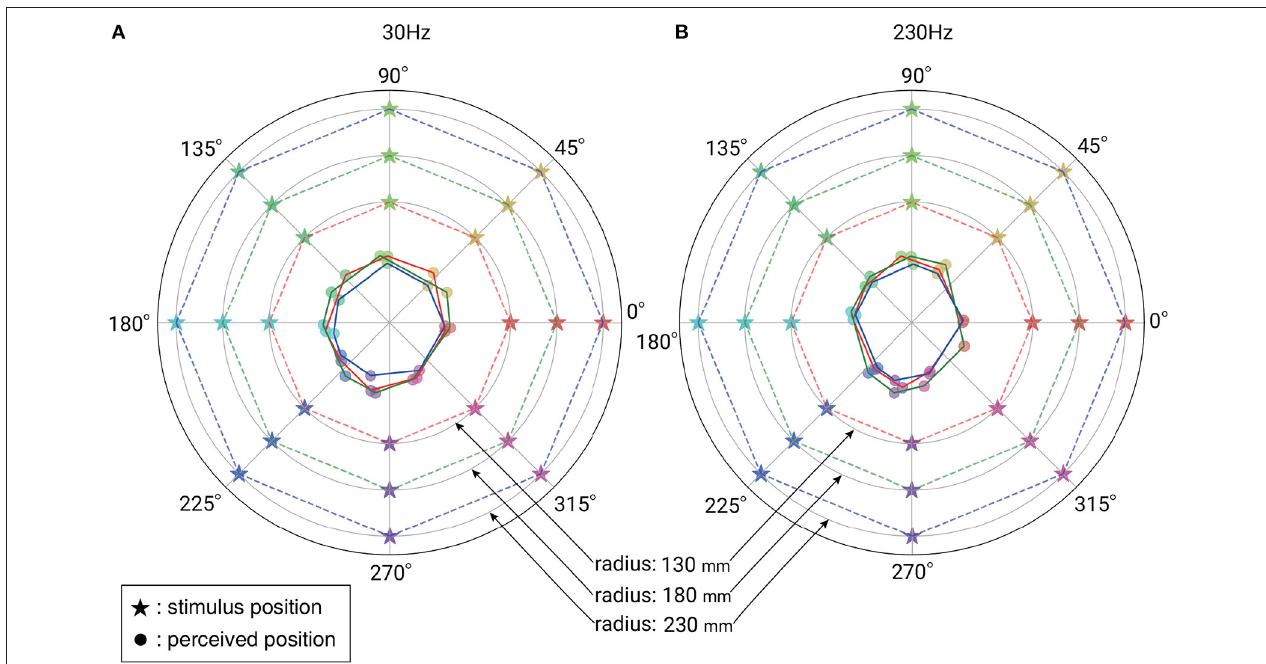
FIGURE 3 | (A) Mean perceived positions for each stimulus in the case of 30 Hz vibration. (B) Mean perceived positions in the case of 230 Hz vibration. A star-shaped marker indicates the stimulus position. A circular marker indicates the perceived position for each stimulus position. The dashed lines and solid lines are visual aids representing the stimulus space and the perceptual space. Use of the same color for the dashed line and solid line means the corresponding relationship of stimulus and perception.